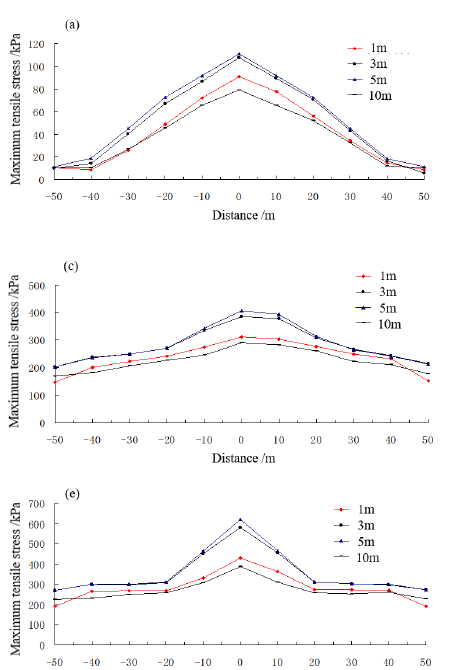
upper tunnel, ( b ) arch of lower tunnel, ( c ) left side wall of upper tunnel, ( d ) left side wall of lower tunnel, ( e ) invert of upper tunnel, ( f ) invert of lower tunnel.